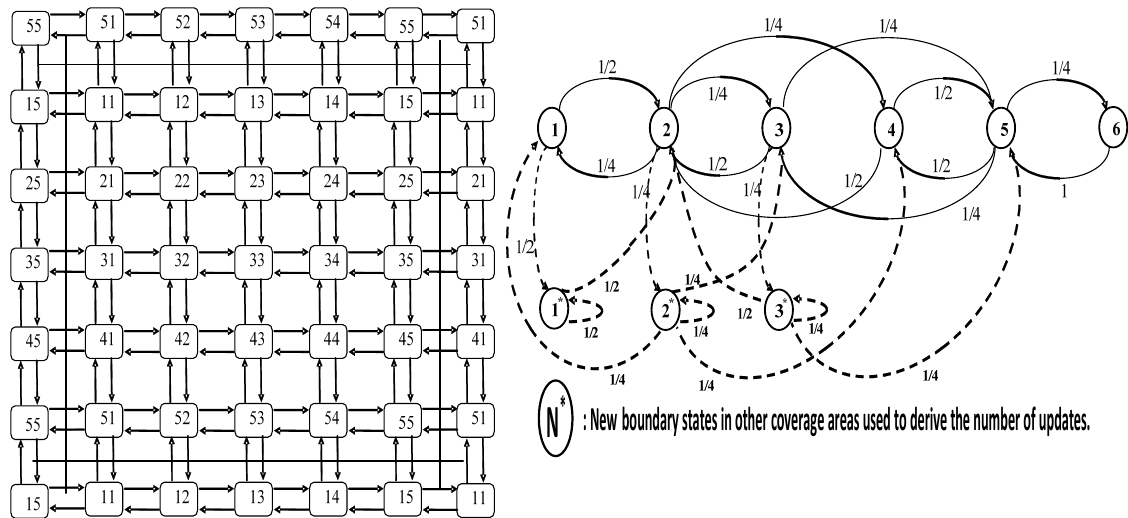
Figure 13. Square shaped cell layout of five-sublayer PAN area model & state diagram.